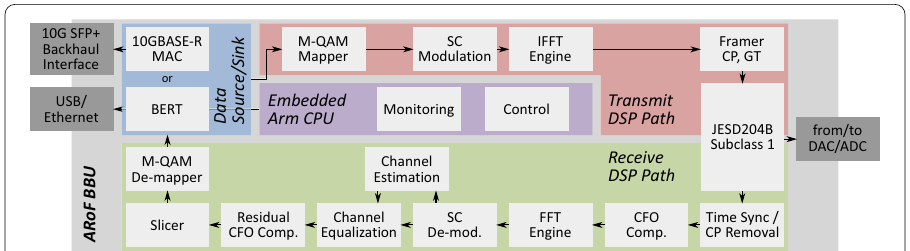
Fig. 2 The blueSPACE BBU with its real-time 5G NR OFDM signal processing architecture. BBU: baseband unit, SFP: small form-factor pluggable, USB: universal serial bus, MAC: medium access control, BERT: bit error rate tester, QAM: quadrature amplitude modulation, CFO: carrier frequency offset, CPU: central processing unit, SC: subcarrier, FFT: fast Fourier transform, IFFT: inverse fast Fourier transform, DSP: digital signal processing,